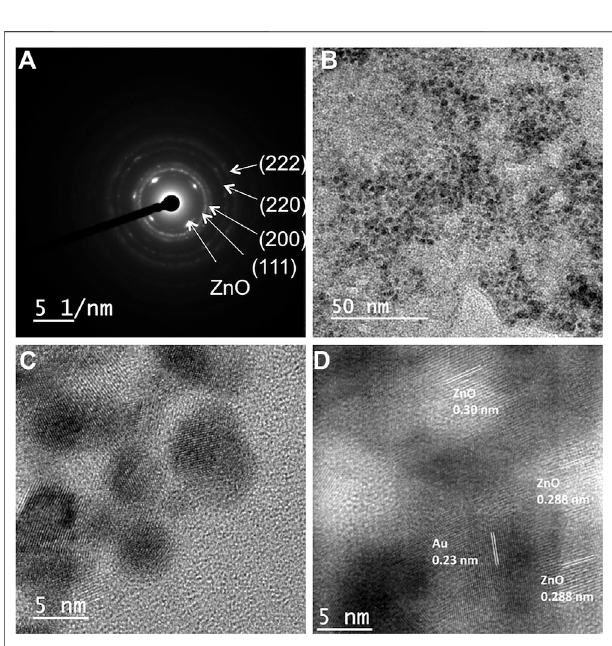
FIGURE 2 | (A) SAED image of cZn4 ; (B) TEM image and (C) HR-TEM showing 5 – 6 nm AuNPs on nanocomposite cZn4 , (D) HR-TEM image showing fringe lines corresponding to both Au and ZnO in cZn4